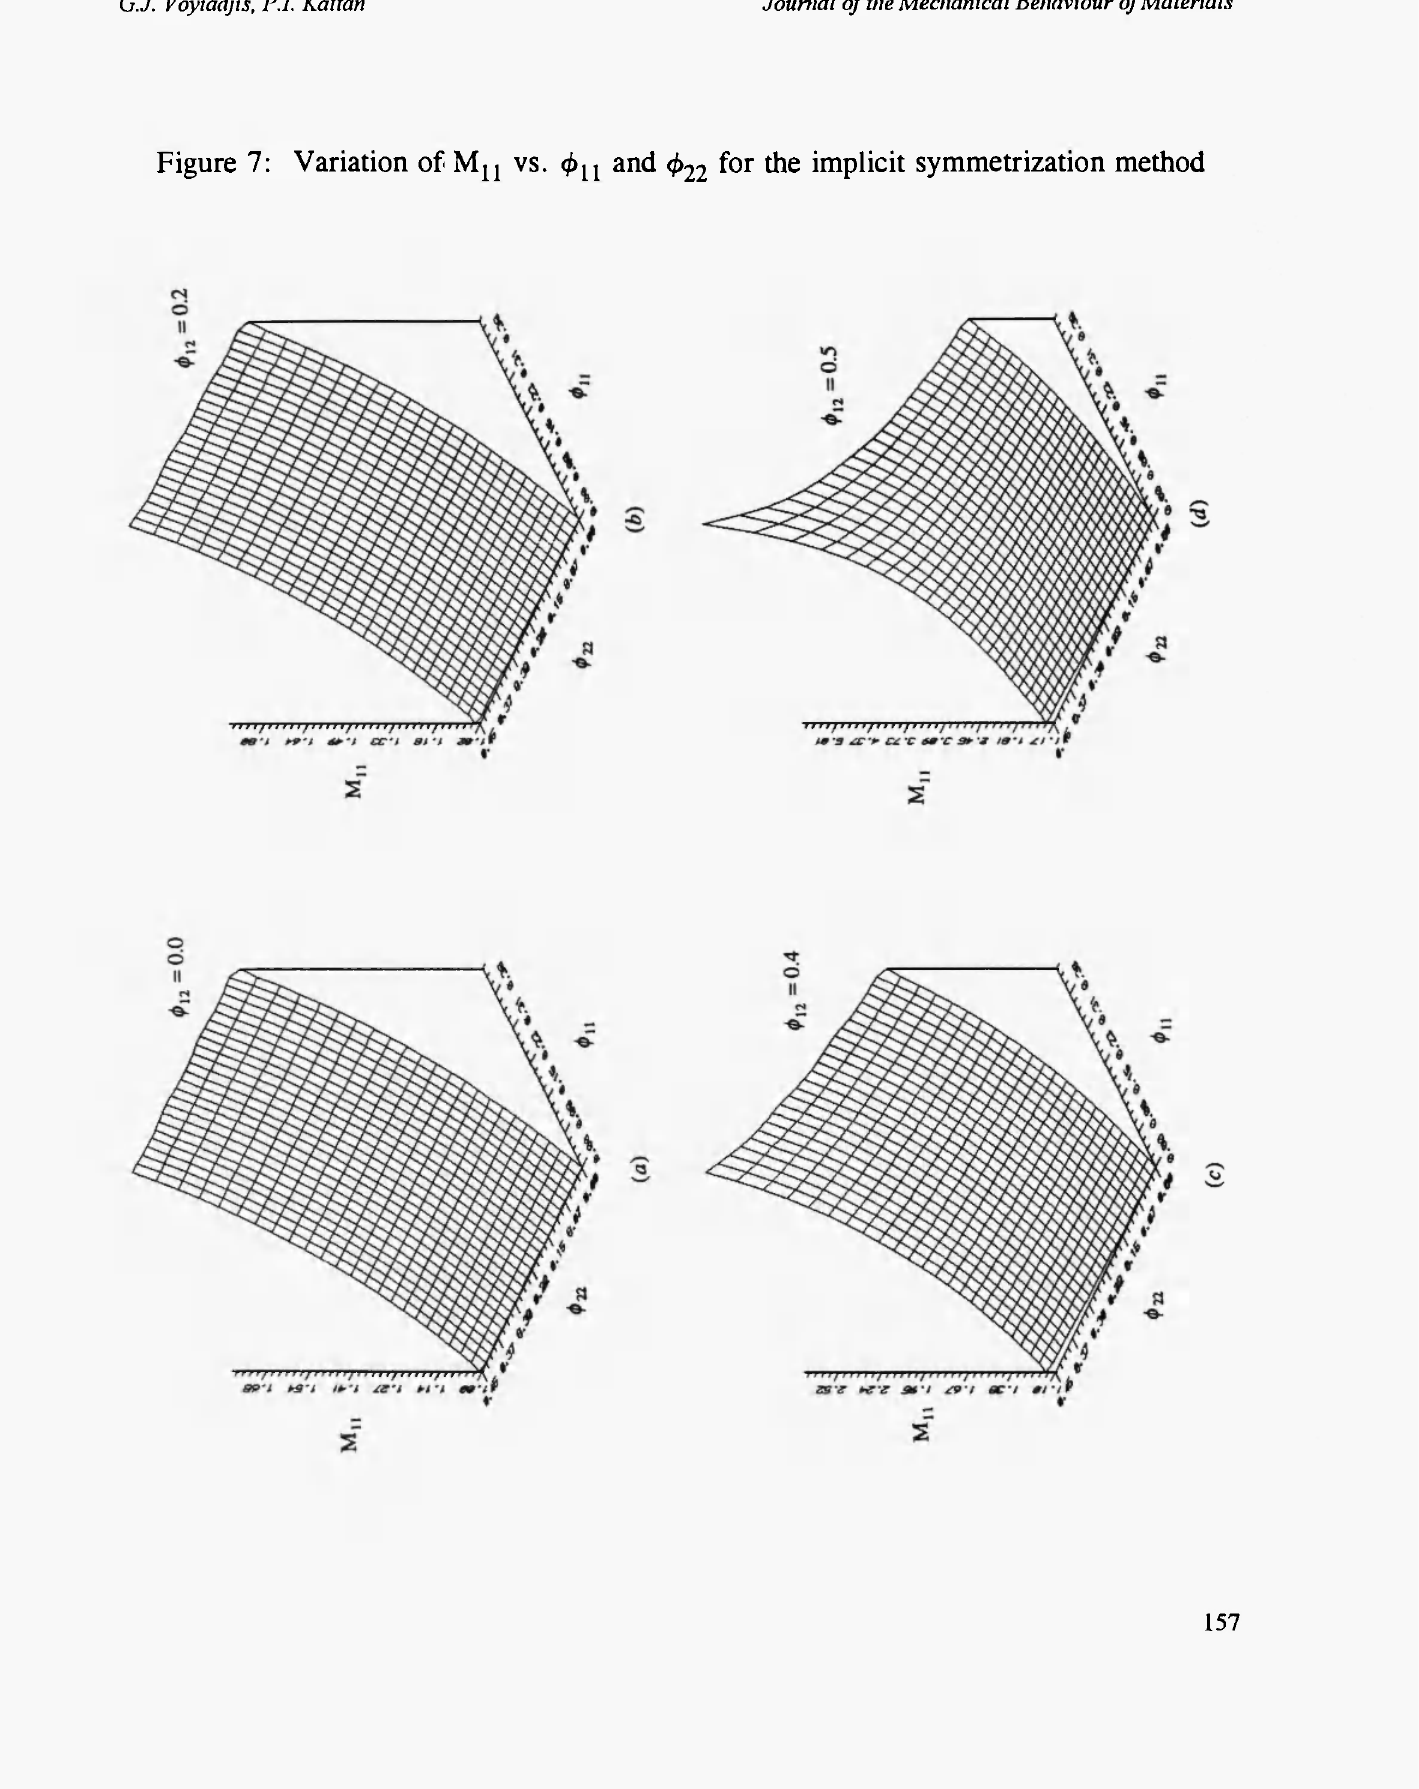
vs. φ and φ for the implicit symmetrization u η 22